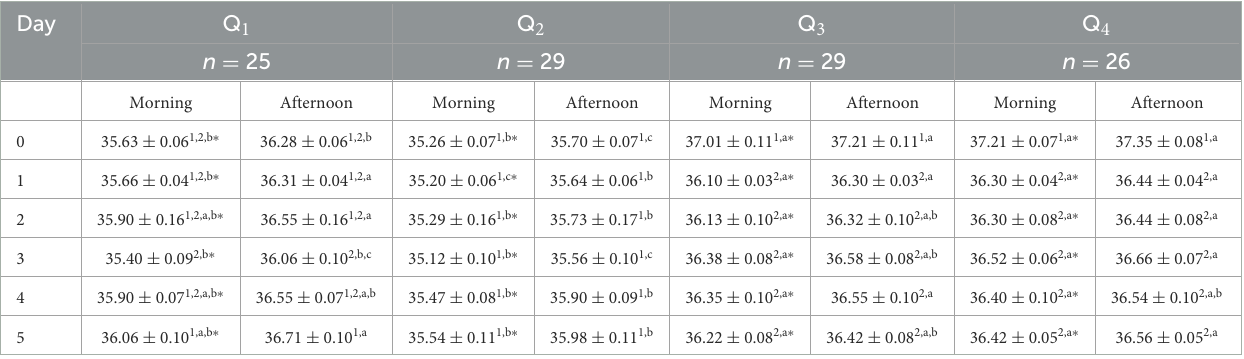
TABLE 3 Mean periocular surface temperature ± standard error (SE) in 109 newborn water buffaloes at different birth weights and daytimes (morning/afternoon) during the first 6 days of